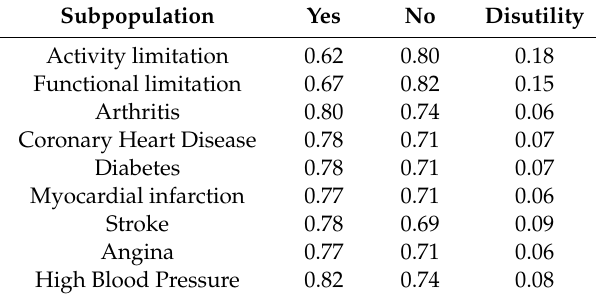
Table 4. Disutility values from the derived Short-Form Six-Dimension (SF − 6D)